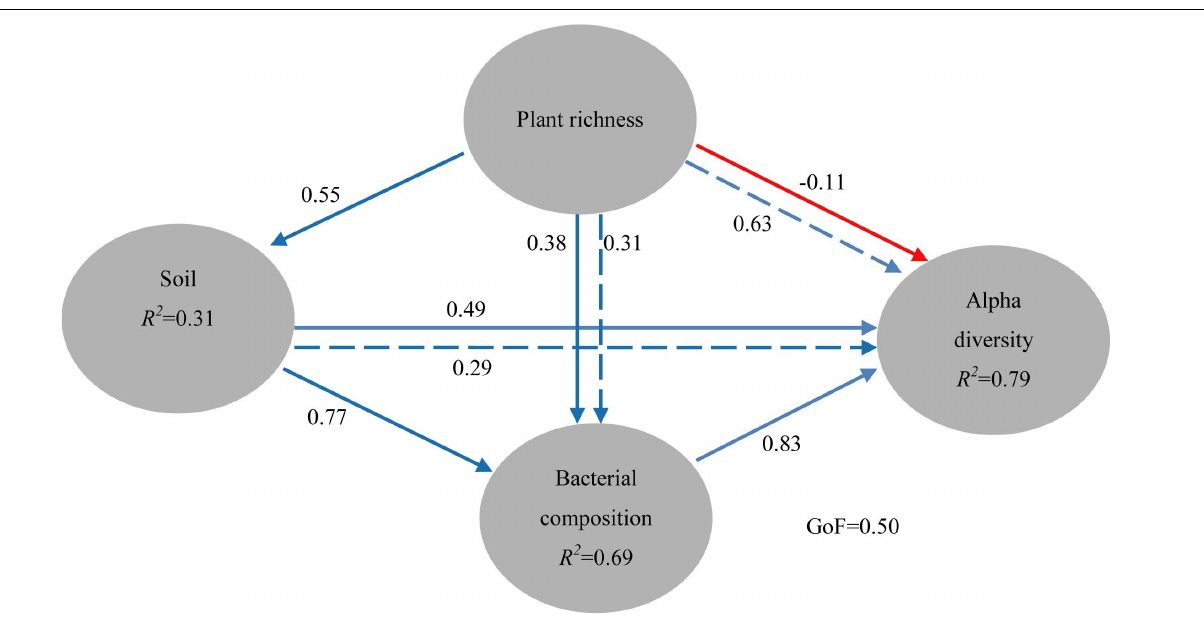
FIGURE 6 | Directed graph of the PLS-PM of plant richness effects on soil properties (pH, SOC, TN, TP, E-Ca, and E-Mg), and soil bacterial community composition (main phyla with the relative abundance higher than 0.1%) and alpha diversity (Chao 1, Simpson and Shannon, observed OTUs, Goods coverage, Fisher index). The path coefficients and the explained variability ( R 2 ) in our study were calculated after 999 bootstraps. Blue solid arrows indicate positive direct effects, red solid arrows indicate negative direct effects, blue dashed arrows indicate positive indirect effects. Models with different structures were assessed using the Goodness of Fit (GoF) statistic, a measure of the overall prediction performance. For the PLS-PM represented here, the GoF was